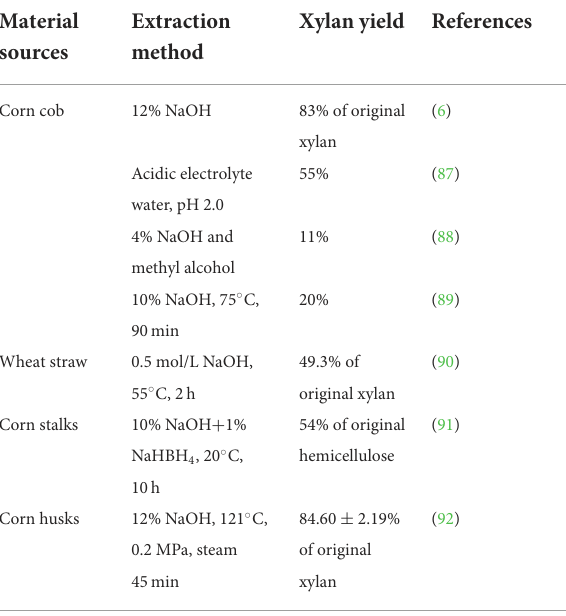
TABLE 2 Material sources, conditions, and xylan yield of commonly used chemical pre-treatment